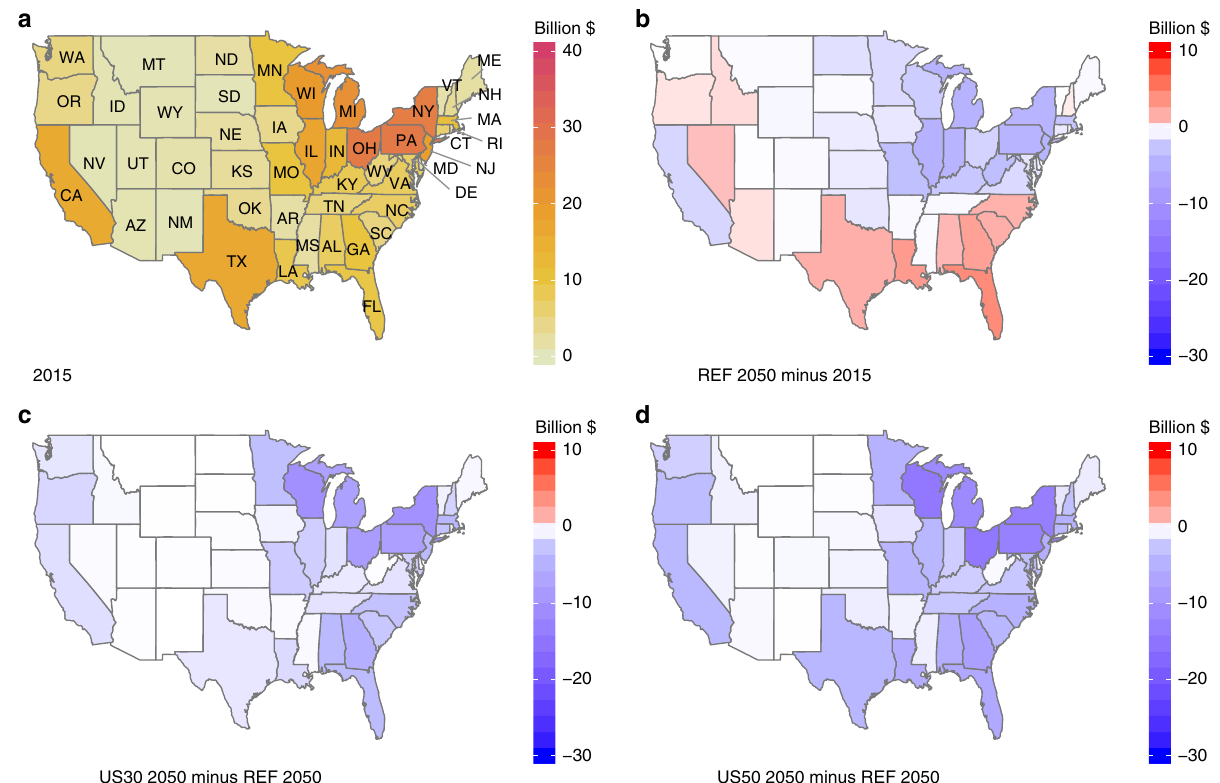
Fig. 4 Regional PM 2.5 -related mortality costs (PMMC) reductions. Estimates of state-level PM 2.5 mortality costs (2018$ billion) in REF for 2015 ( a ), and absolute changes ($ billion) in REF by 2050 ( b ). Changes in PMMC relative to REF for US30 in 2050 ( c ) and US50 in 2050 ( d ). In REF, a number of states will face challenges in reducing their PMMC from 2015 to 2050. When applying national reduction targets, all states will have lower PMMC relative to 2015. This is meaningful for long-term air quality management, especially among states with high existing PMMC (such as PA and OH) and states with increasing PMMC in REF (such as TX and FL). Source data are provided as a Source Data fi